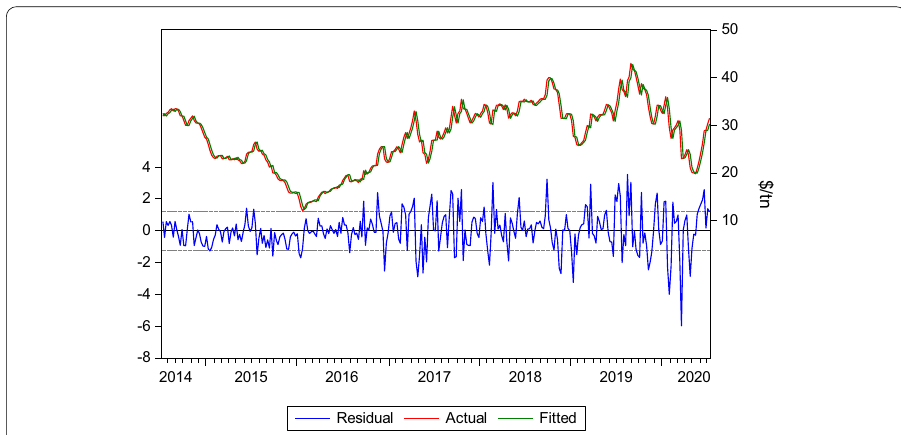
Fig. 4 Santos–Qingdao grains. Source : Elaboration by the authors